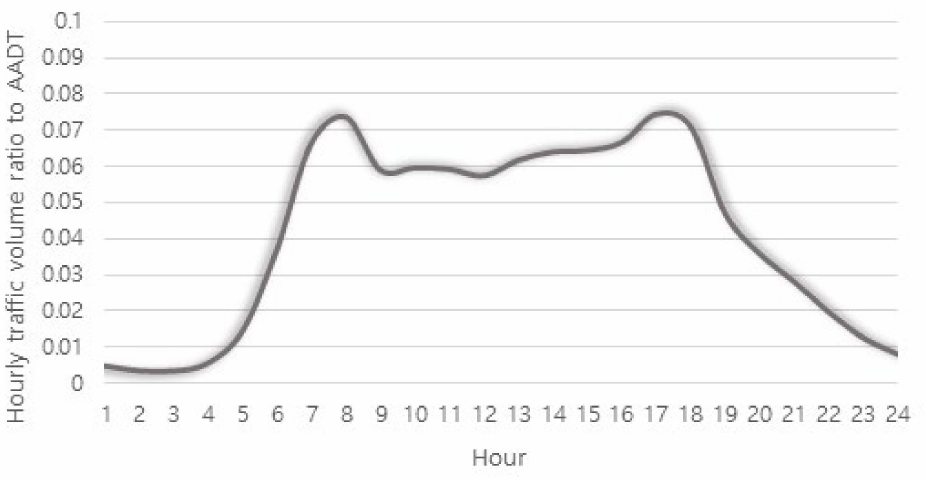
Figure 4. Annual average hourly traffic volume ratio to AADT (weekdays) for the national highways in